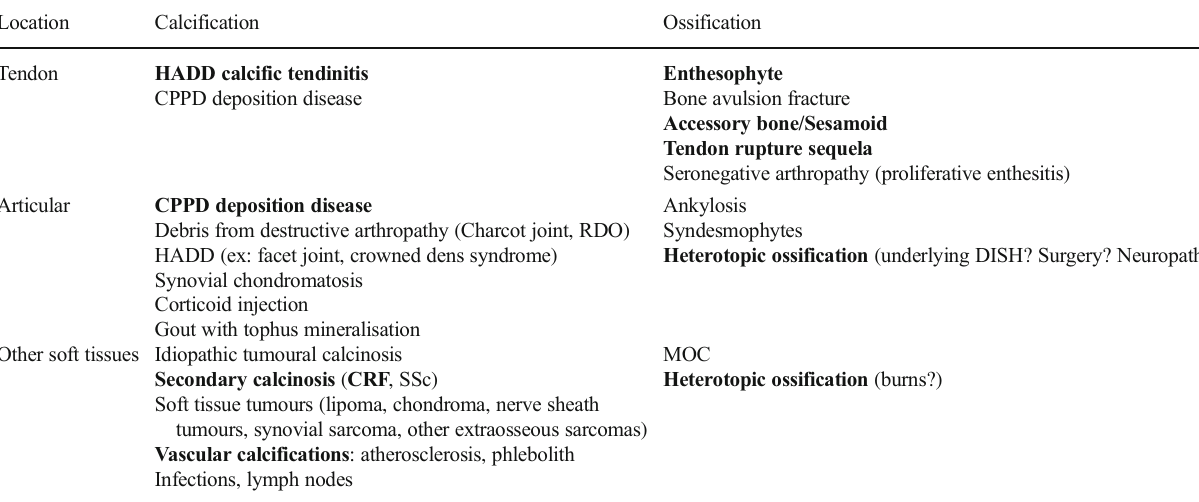
Differential diagnosis of calcifications and ossifications according to their location